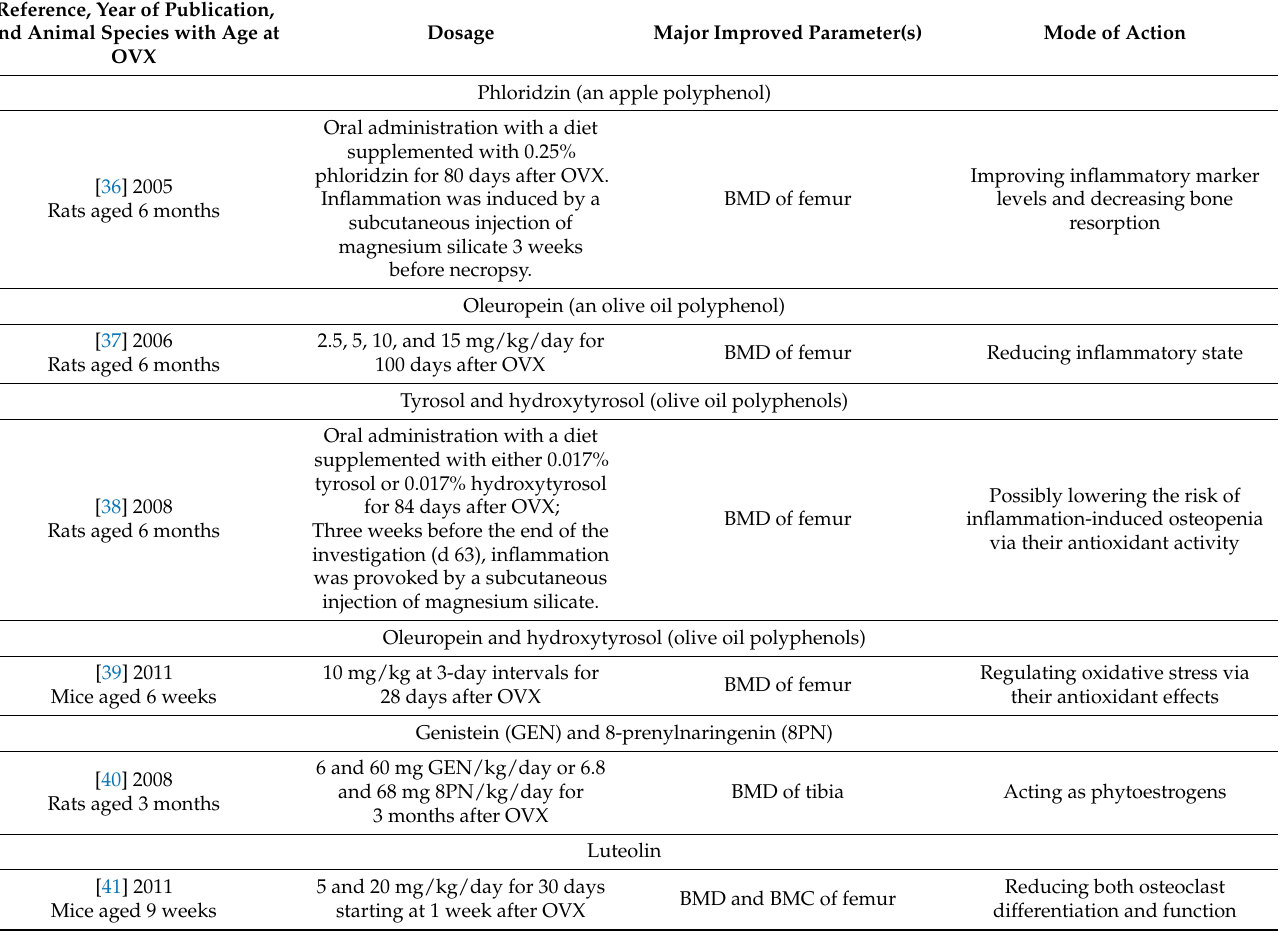
Table 2. Beneficial effects of oral purified-polyphenolic compounds other than resveratrol on osteo- porosis in ovariectomized